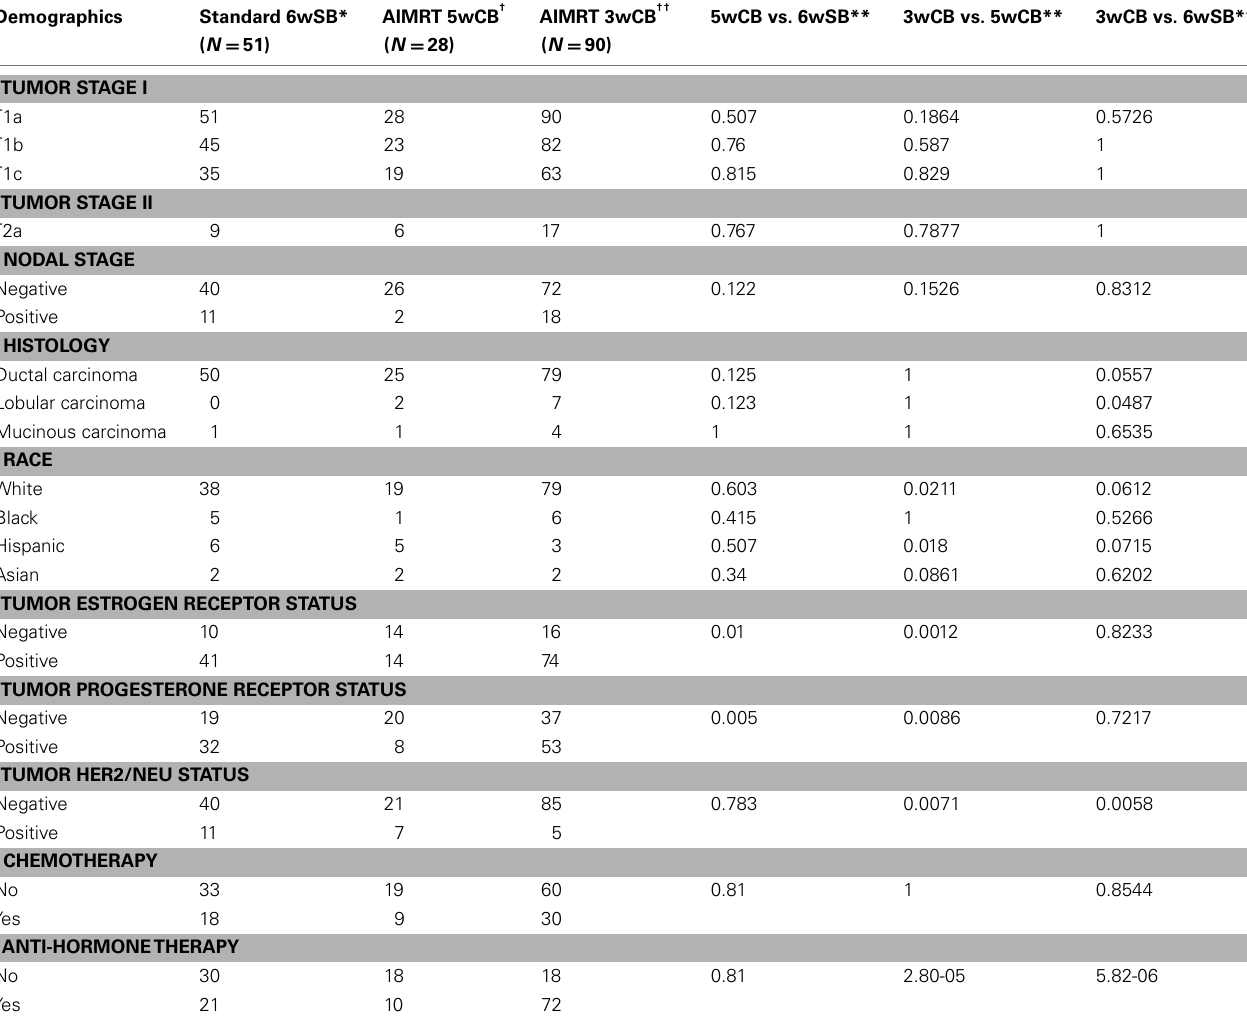
Table 3 | Distribution of baseline patient and tumor characteristics among the three groups of